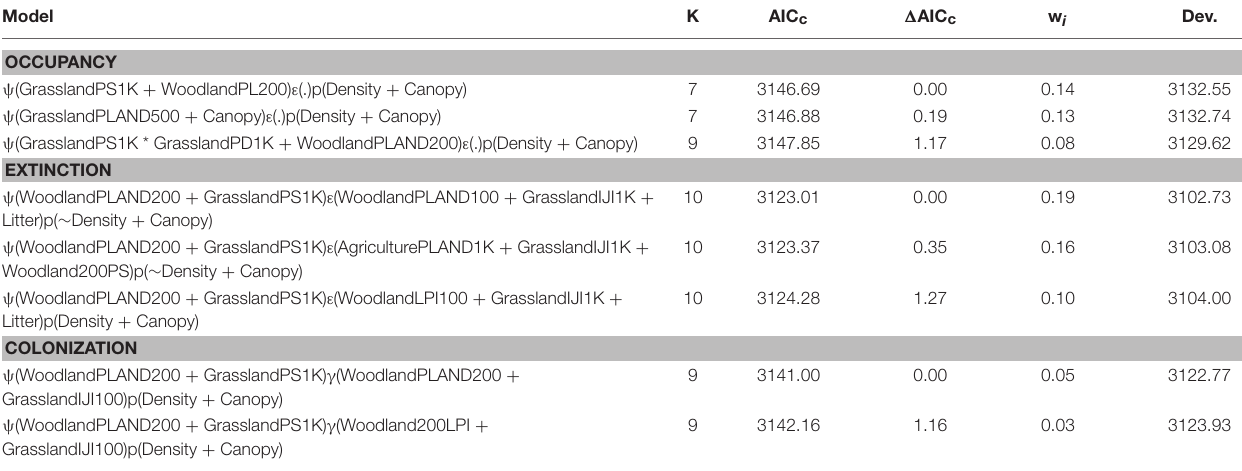
TABLE 6 | Model selection results for site occupancy ( ψ ), site extinction ( ε ), site colonization ( γ ), and detection probability (p) for monarchs surveyed in Iowa, 2006–2017. Model K AIC c 1 AIC c w i